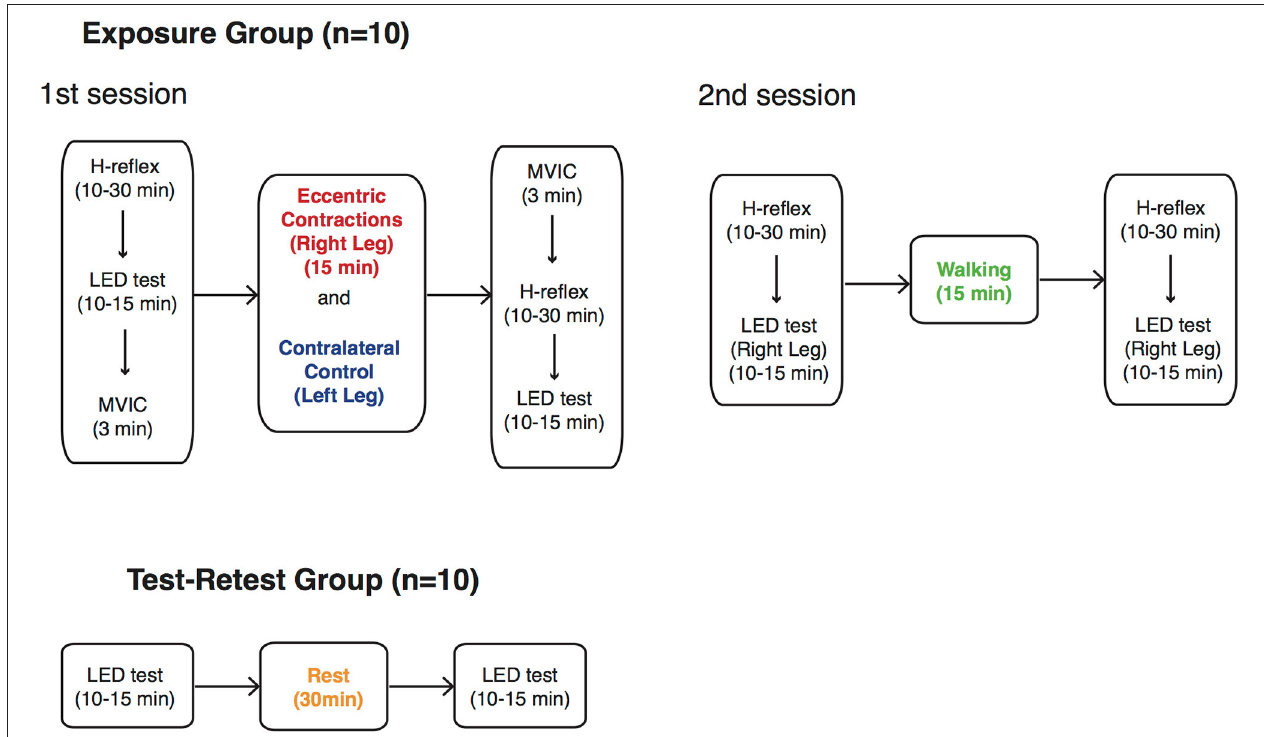
FIGURE 4 | Summary of testing protocol. Ten subjects from Exposure group were exposed to two different interventions, eccentric contractions (ECC) and walking (WALK), in two separate sessions. During the first session, the contralateral leg remained at rest (CONTRA). Another set of 10 subjects (Test-Retest group) participated in an experiment where they performed the LED test bilaterally twice with 30-min rest in between. The order of measurements is shown with the duration required to complete each outcome